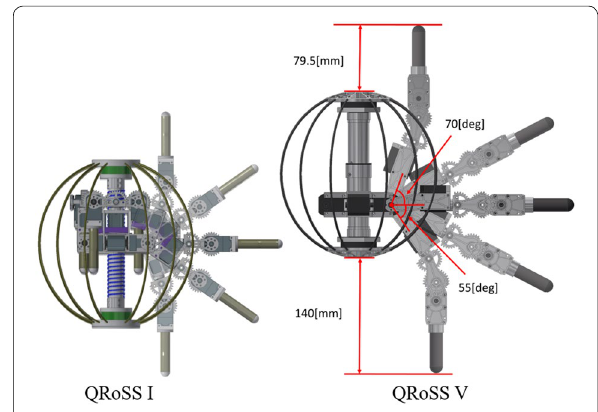
Fig. 6 Comparison of leg work range in vertical direction